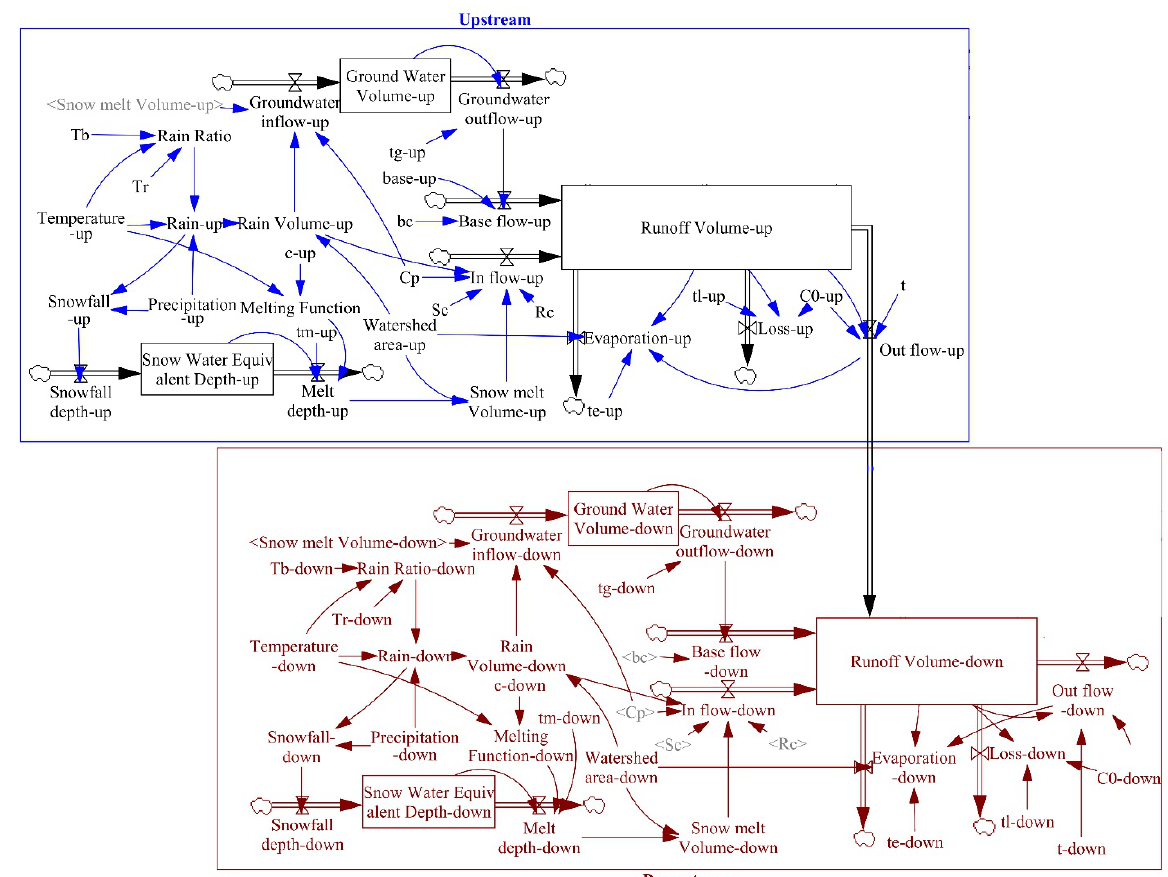
Figure 9. The hydrologic system dynamics model for the upstream-downstream scenario. To apply the model for this scenario and demonstrate that the upstream has a higher potential runoff, its CN curve number is assumed to be 89 and for downstream CN is considered to be 79. The coupled model is solved with monthly time step, with results shown in Figure 10.